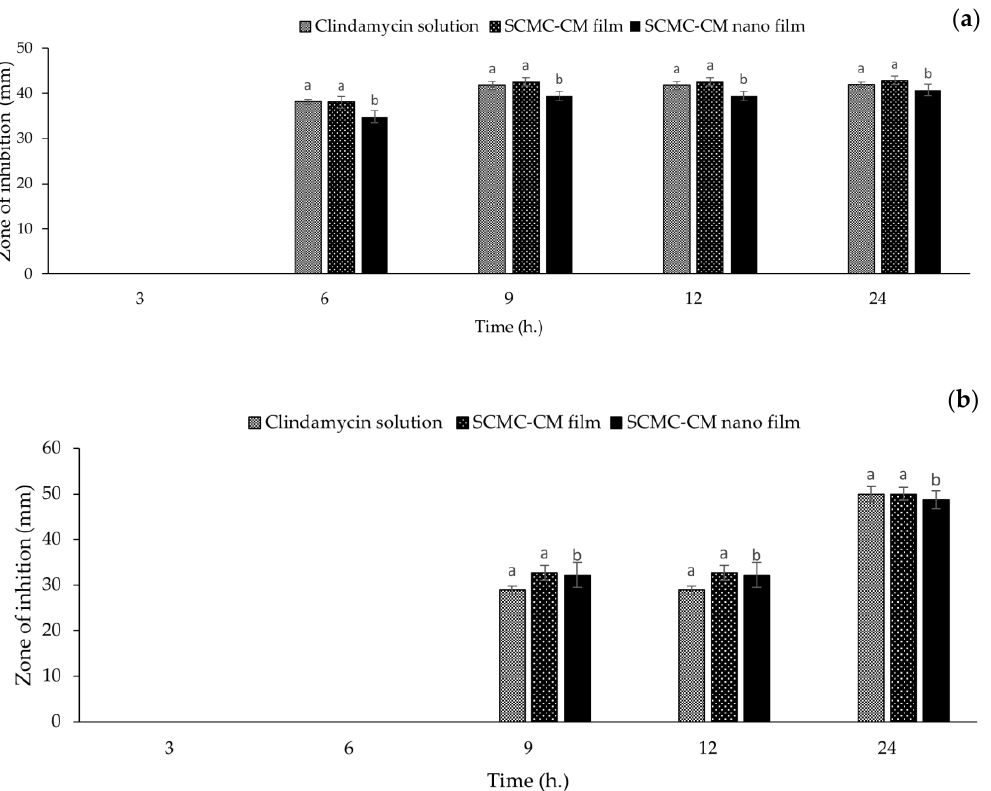
Figure 8. Antibacterial activity of clindamycin HCl solution, SCMC film containing clindamycin HCl powder (SCMC-CM-powder) and SCMC film containing clindamycin CMCS-Ca 2+ nanoparticles (SCMC-CM-nano) against S. aureus ( a ) and C. acnes ( b ). Note: Different letters above the graphs indicate significant difference ( p < 0.05).